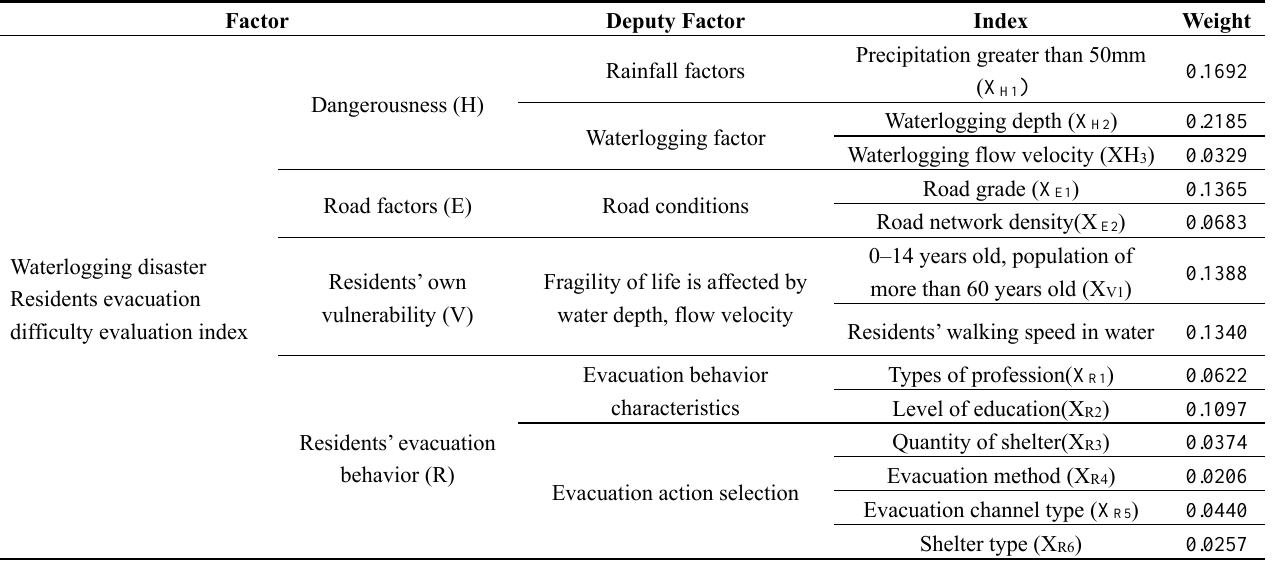
Note: Table 2 graded and scored using expert scoring method. Table 3. Difficulty evaluation index system and weight of residents’ evacuation at urban rainstorm waterlogging